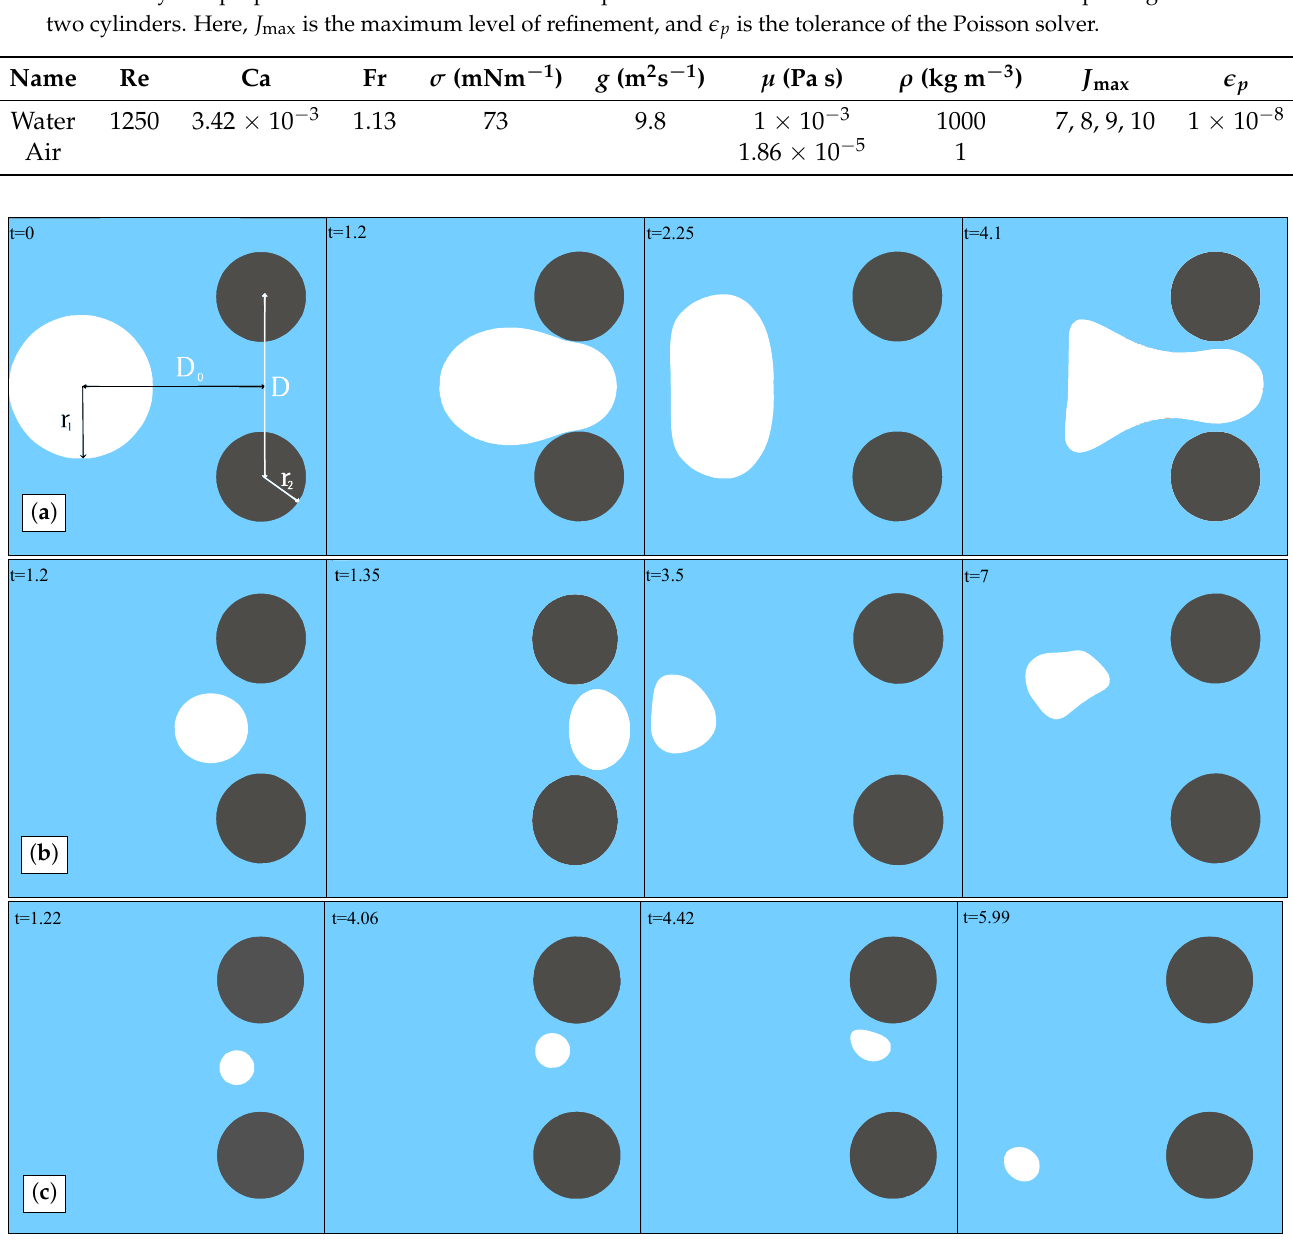
Figure 9. Air bubble passing between two fixed cylinders . Snapshots at different times t are shown. The cylinders of radius r 2 = 0.125 are spaced D = 0.5 units apart between their centers. The bubble is placed initially at distance D 0 = 0.5 from the centerline between the cylinders. The bubble radius is: ( a ) r 1 = 0.2; ( b ) r 1 = 0.1; (c) r 1 = 0.05.